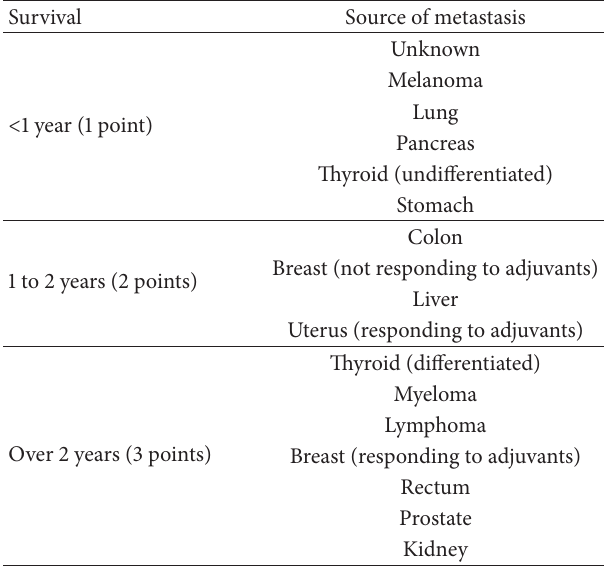
Table 4: Predictive survival and scoring for the protocol.